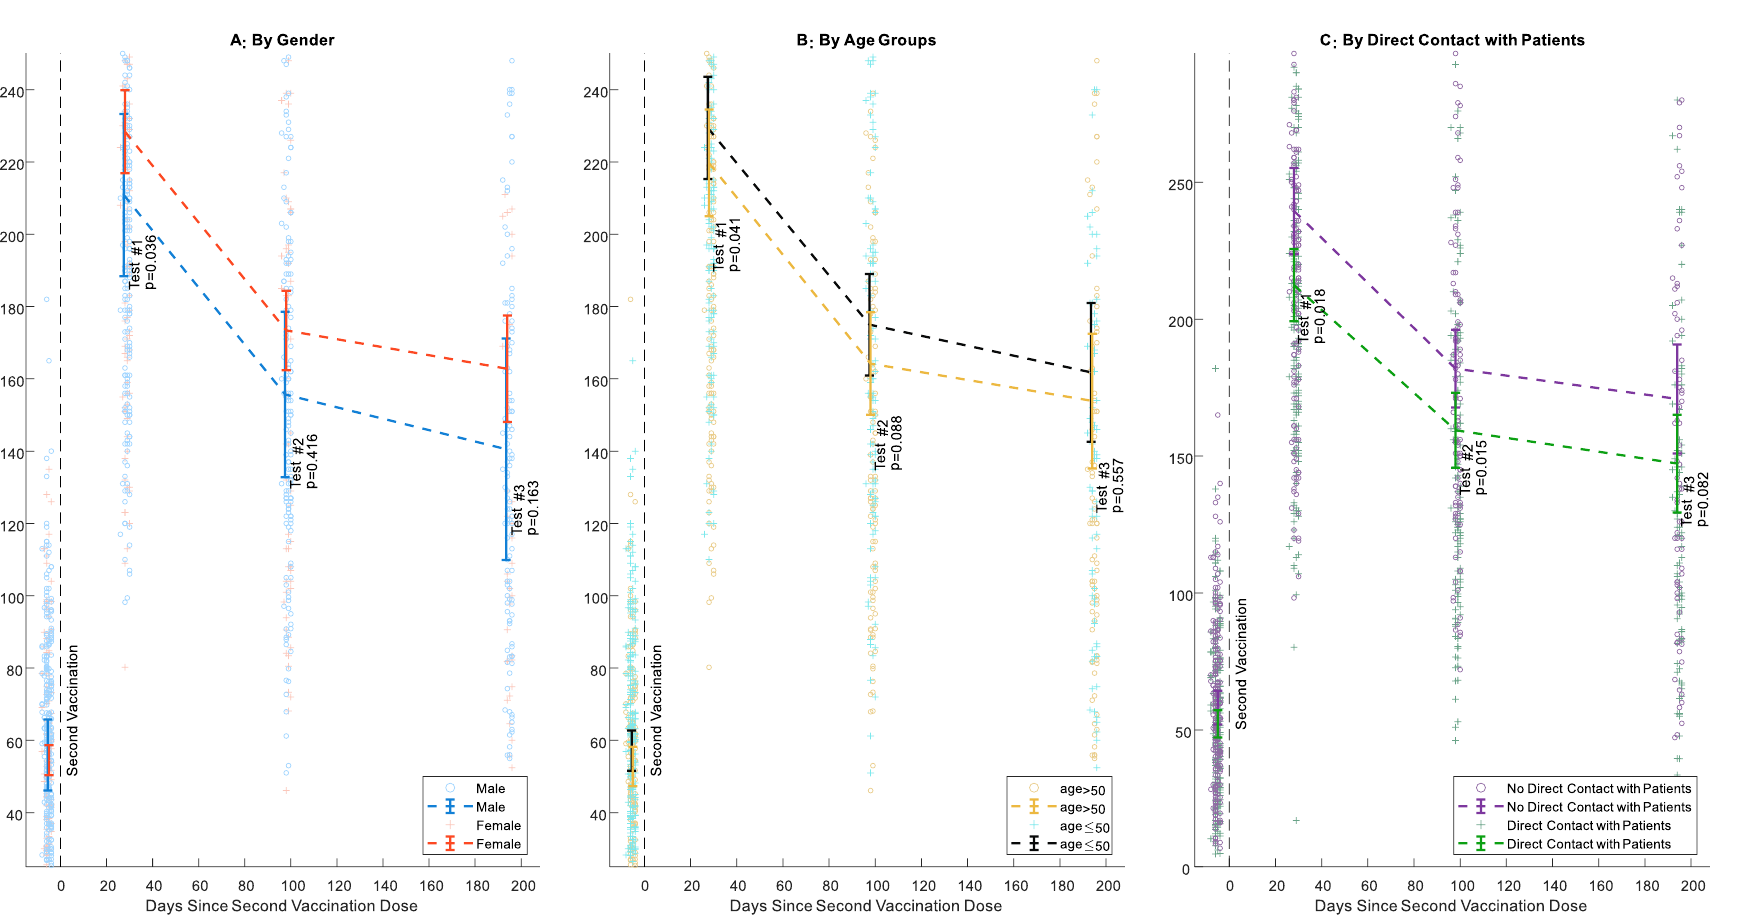
Figure 2. IgG anti-S Levels Over Time. ( A ) Gender; ( B ) age (50 or younger, Older than 50); ( C ) direct patient contact. Circles and crosses represent individual IgG Anti-S values; means and 95% confidence intervals are only calculated for the comparable sample.